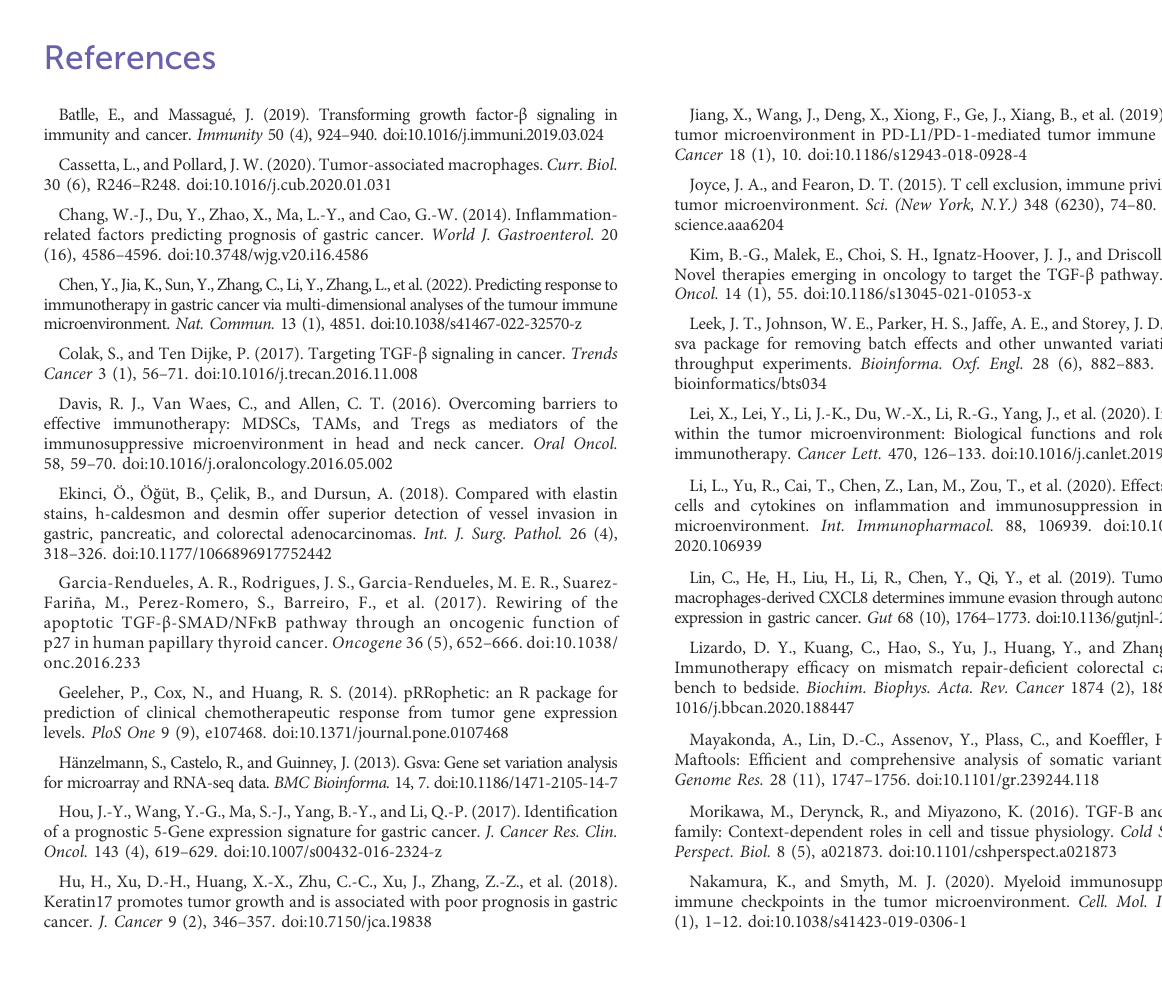
Schematic diagram of the study design. SUPPLEMENTARY FIGURE S2 Riskmodelvalidationontheimvigor210cohort. (A) Kaplan – Meiersurvival analysis between high- and low-risk groups. (B) Immunotherapy response analysis. CR: Complete response; PR: Partial response; SD: Stable disease; PD: Progressive